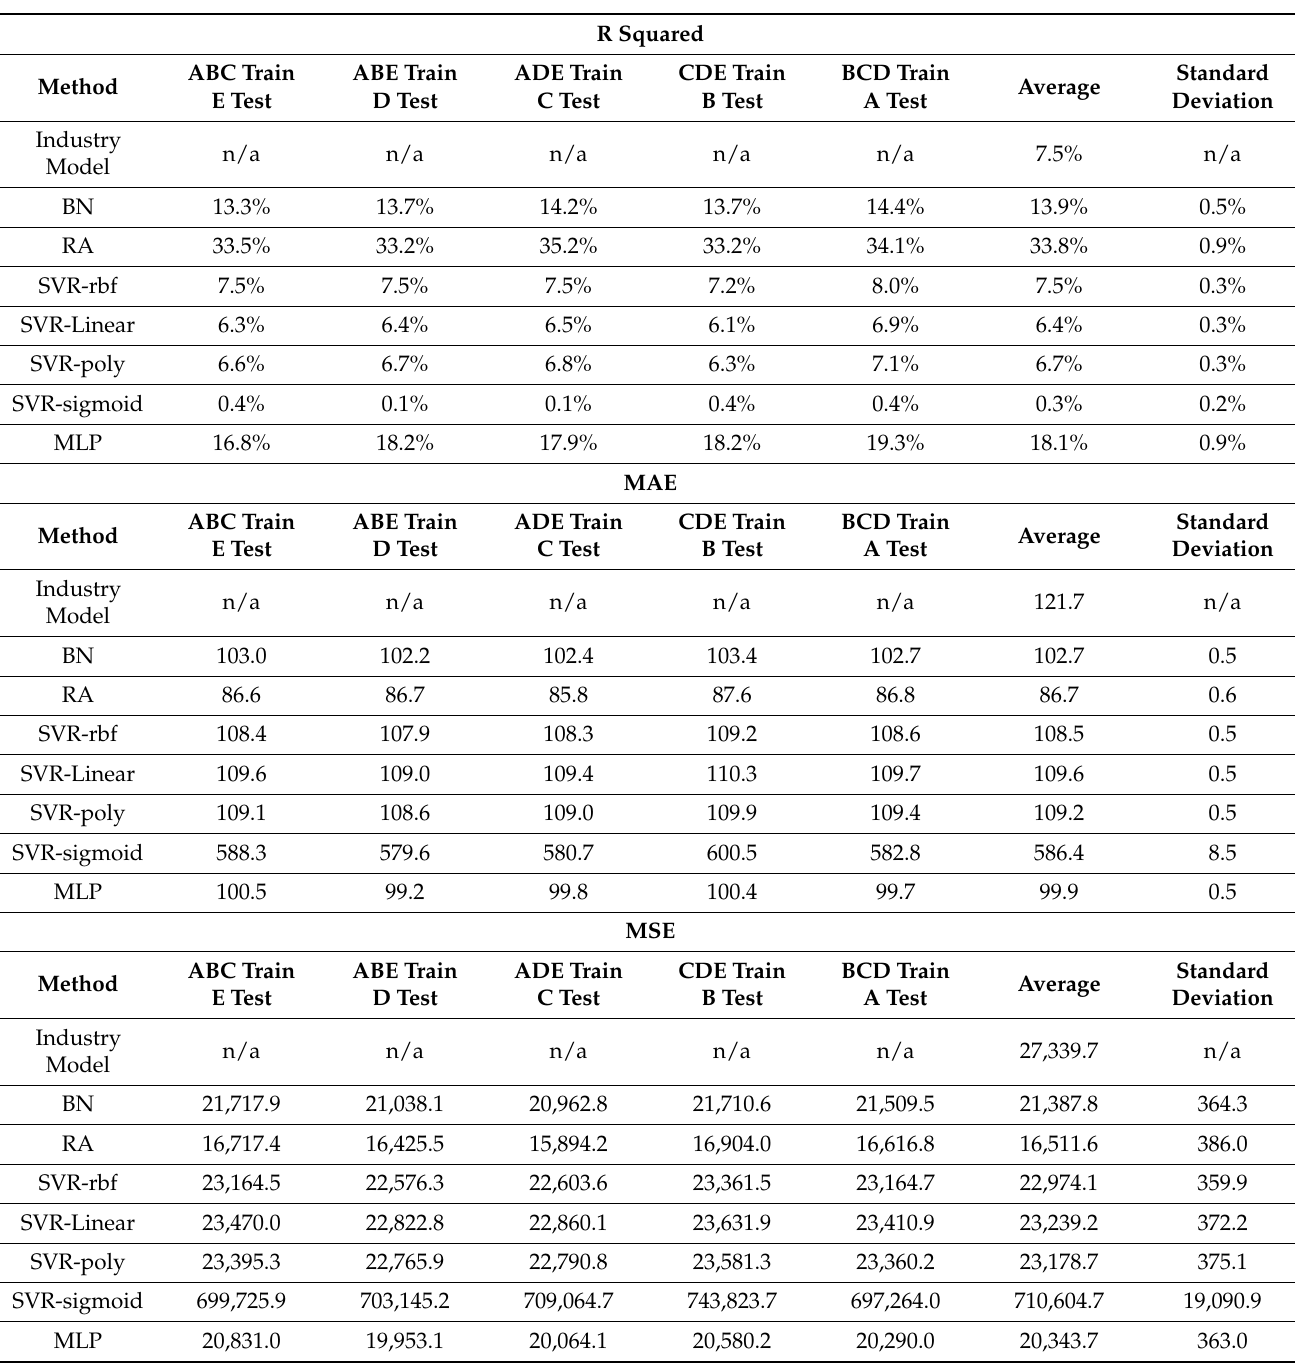
Table 4. Results of Industry Model and Machine Learning